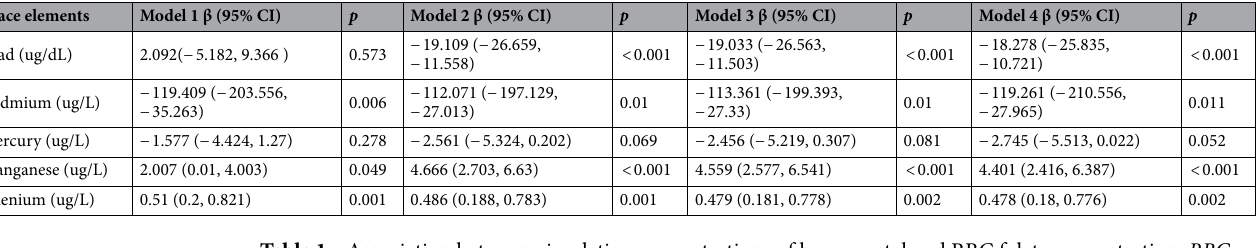
Table 1. Association between circulating concentrations of heavy metal and RBC folate concentration. RBC red blood cell, CI , confidence interval. β coefficients were interpreted as change of RBC folate concentration for each increase in different trace elements concentration. Adjusted covariates: Model 1 = Unadjusted model; Model 2 = Adjusted for age, sex and race/ethnicity; Model 3 = Model 2 + platelet count, urinary albumin, ALT, total bilirubin, and creatinine; Model 4 = Model 3 + history of smoked (defined as ever smoked at least 100 cigarettes in a lifetime).